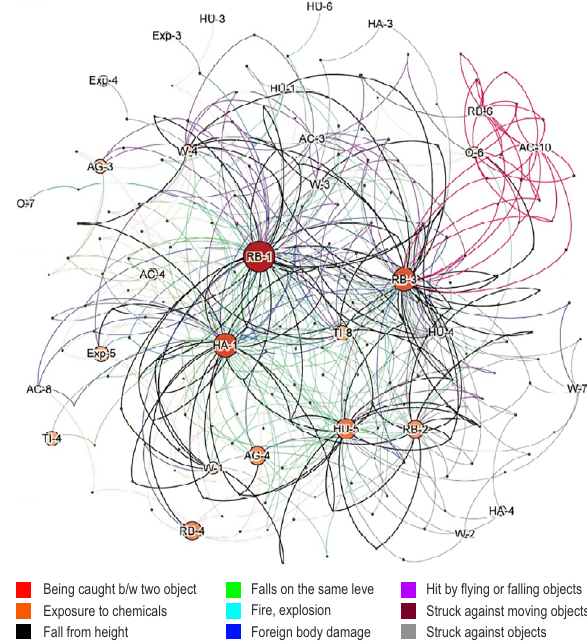
Figure 5. Visualization of a network for 202 rules (All